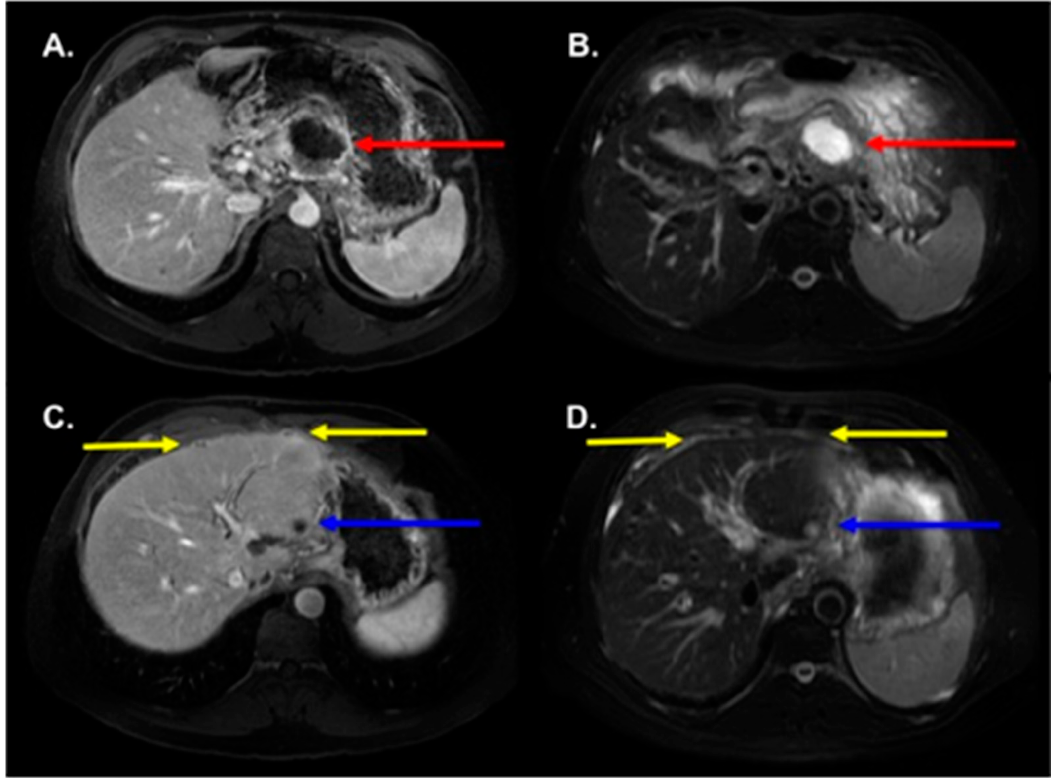
Figure 1. A 48-year-old male with a necrotic mass in the pancreatic body. ( A ) Axial T1 fat-suppressed portal venous phase image demonstrates central hypo-enhancement (red arrow). ( B ) Axial T2 fat-suppressed image shows associated hyperintensity (red arrow). ( C , D ) Hypo-enhancing, T2 hyperintense lesions are seen within the liver (blue arrows) and along the anterior hepatic capsule (yellow arrows). Endoscopic ultrasound biopsy revealed primary PDAC with necrosis.